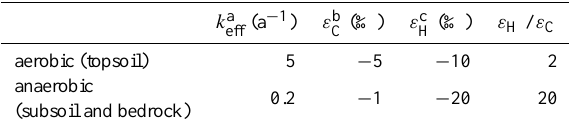
Table 2. Parameters for degradation and isotope